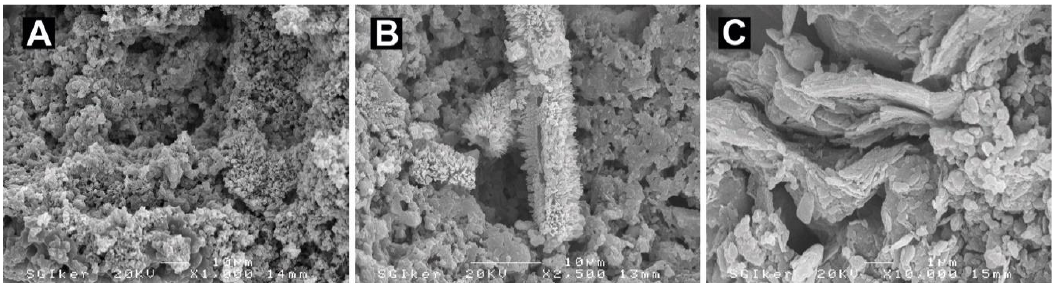
Figure 4. Scanning electron microscope (SEM) images of: ( A ) bulk calcite of the marmorino layer, ( B )